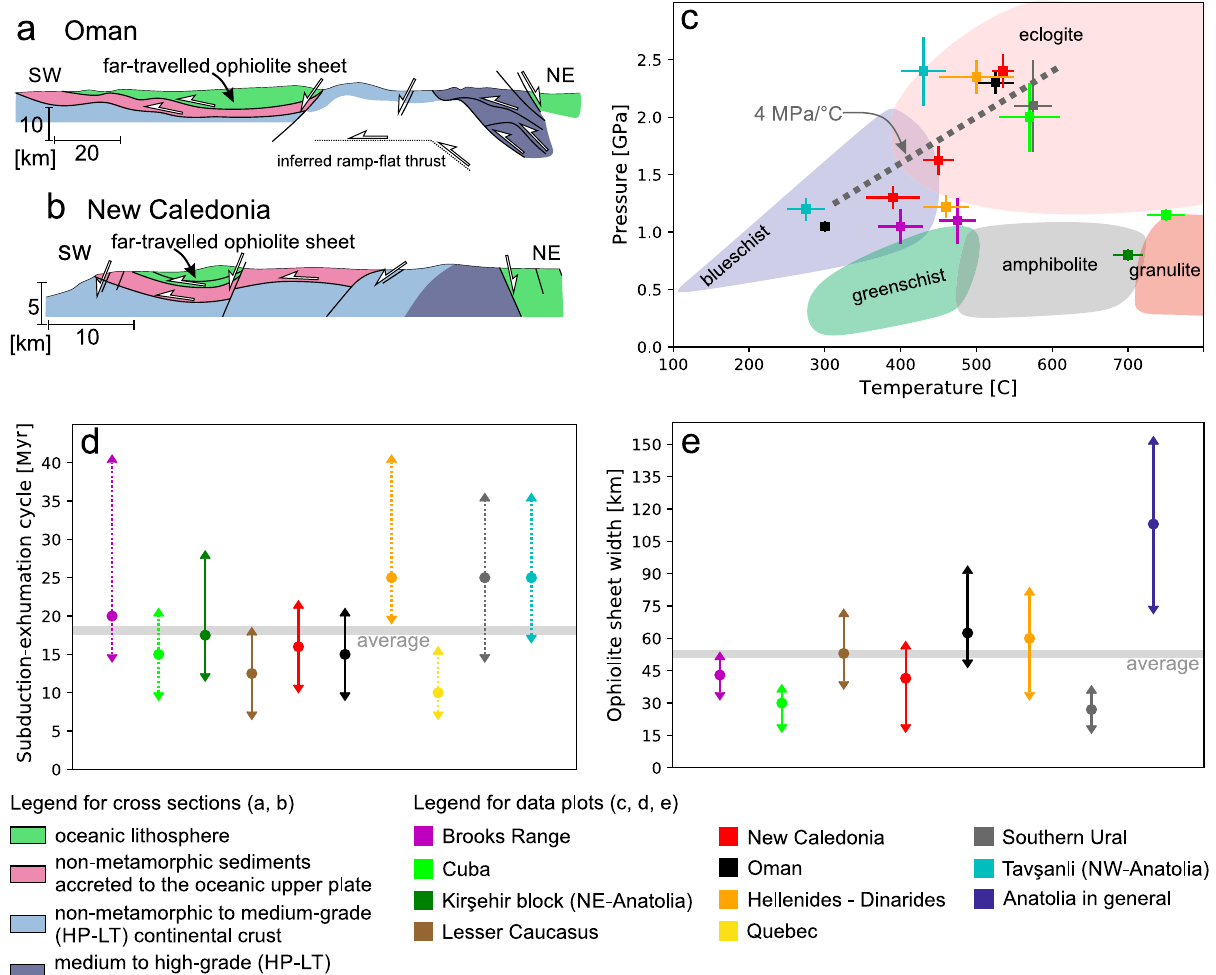
Fig. 1 Datasets collected from natural ophiolite belts. For detailed explanation and references regarding the datasets ( c – e ) see Supplementary Note 1 and Supplementary Tables 1 and 2. Simpli fi ed cross sections showing the structure of the Oman 13 ( a ) and New Caledonia 56,57 ( b ) ophiolites and their structural relationship to the underlying continental rocks. The far-travelled ophiolite sheets are separated from their oceanic root by exhumed continental units, which show a transition from non-metamorphic to high metamorphic grade. c Peak pressure-temperature ( P-T ) data collected from the subducted and exhumed geological units in natural ophiolite belts. Multiple data points from the same location represent the peak conditions of different structural levels. Error bars represent the uncertainty of thermodynamic calculations. d Duration of the continental subduction-exhumation cycle below the oceanic upper plate as recorded by the buried and exhumed continental formations. The duration is calculated from the arrival of the continental margin in the subduction zone to the near surface/surface exhumation of the subducted formations and is indicated by colored circles. Error bars show uncertainties associated with the duration of the subduction-exhumation cycle, where solid lines re fl ect well-constrained and dotted lines poorly constrained cases, respectively (see Supplementary Note 1). e Average width of far-travelled ophiolite sheets (colored circles) and the deviation from the average along strike (error bars) in natural ophiolite belts. The width was measured along 3 – 8 cross sections along each ophiolite